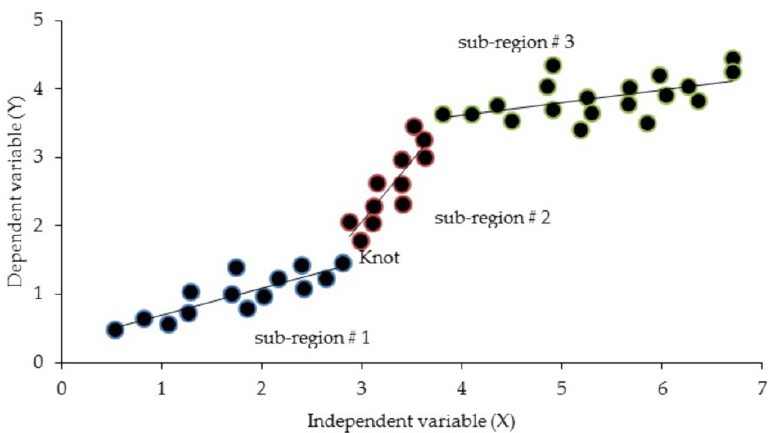
Figure 4. A schematic sketch for the illustration of sub-regions of the MARS method. The segments of X–Y relationships are divided into break values known as knots.